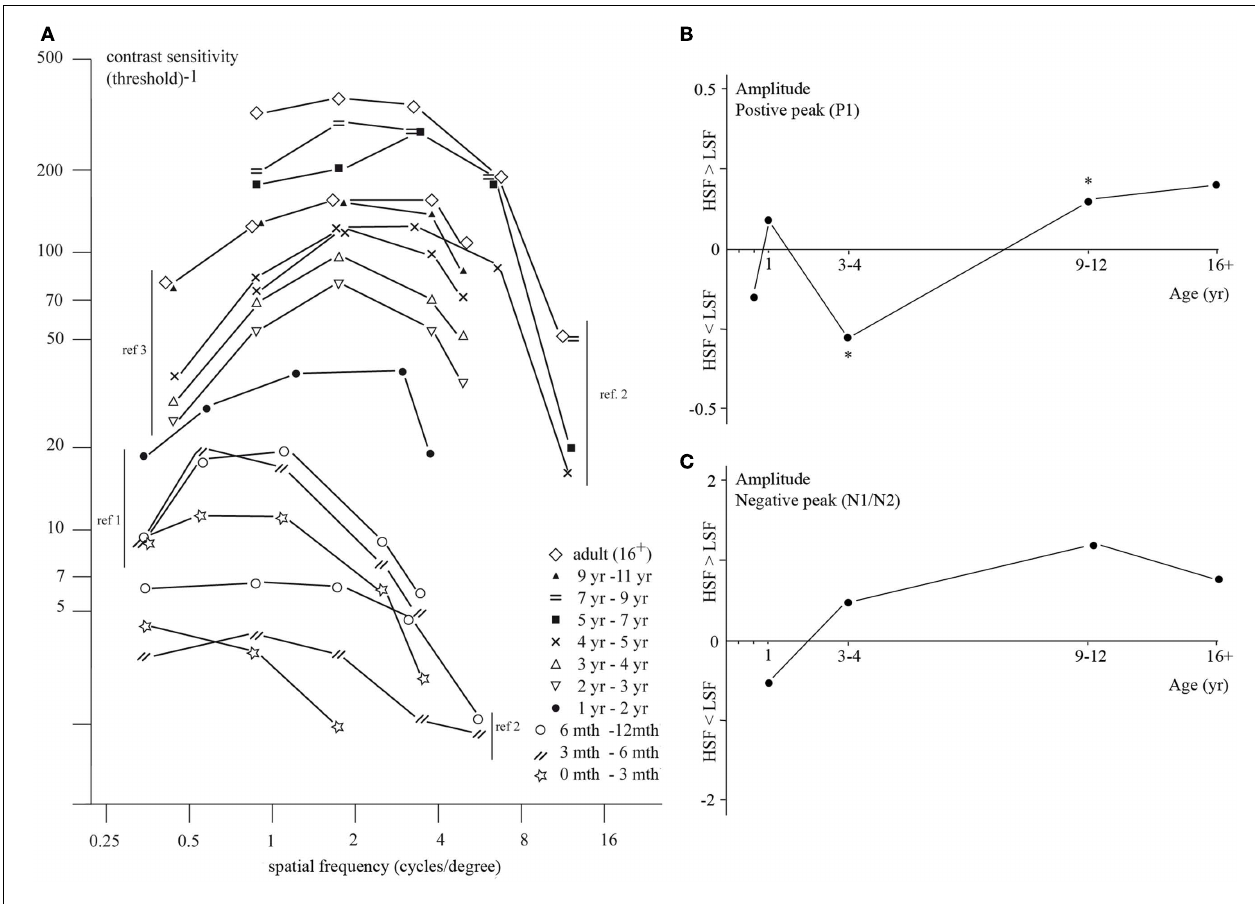
evoked by high versus low SFs; calculated as (HSF − LSF)/HSF] of the negativeVEP peak (N1 or N2) at different age groups. Specific SFs for calculation of the relative amplitude value are those of the stimuli in studies investigating the depicted age ranges, and are further specified below. Asterisks represent significant amplitude differences evoked by high versus low SFs, noted by the authors of the